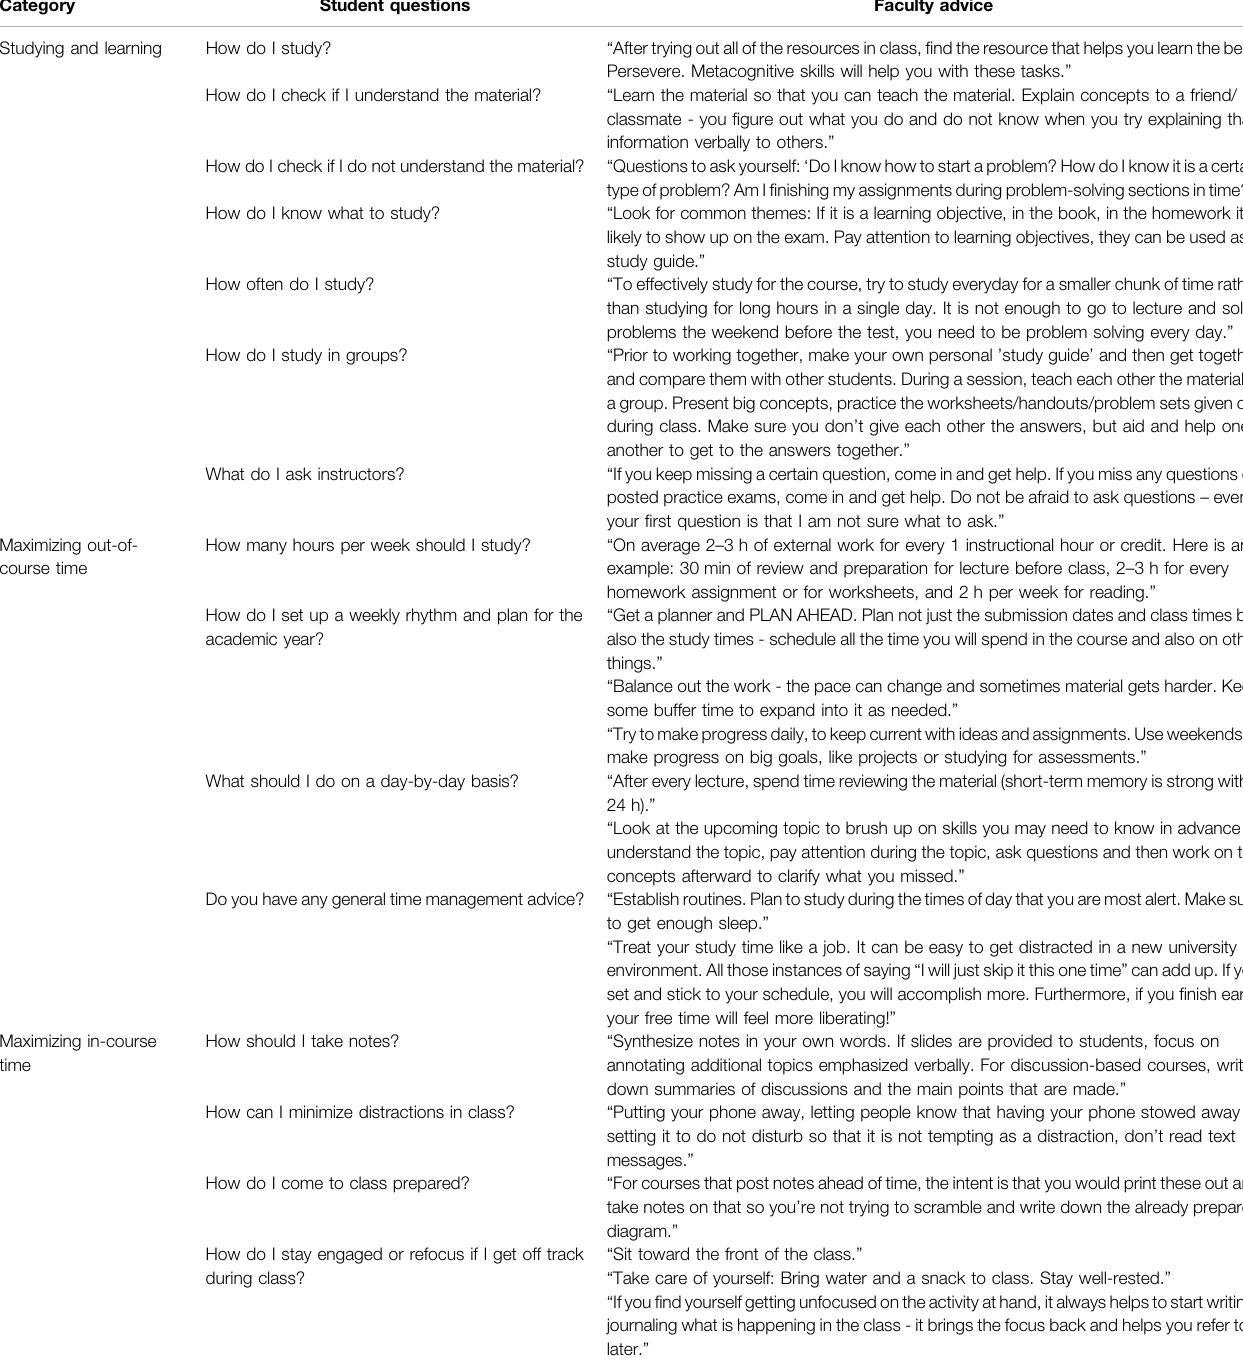
TABLE 1 | Representative student questions and corresponding advice from faculty.